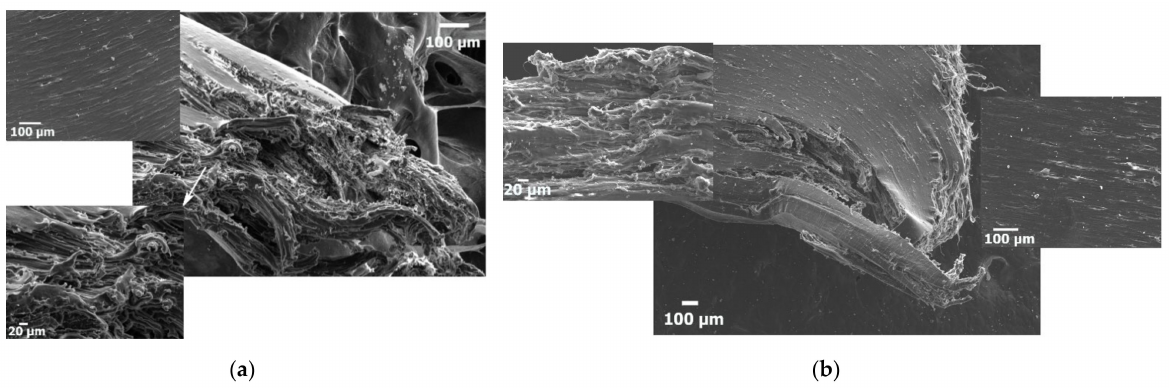
Figure 5. SEM images of the fracture surfaces of ( a ) SCB-PE/2.5 GNPs no BM and ( b ) SCB-PE/2.5 GNPs w